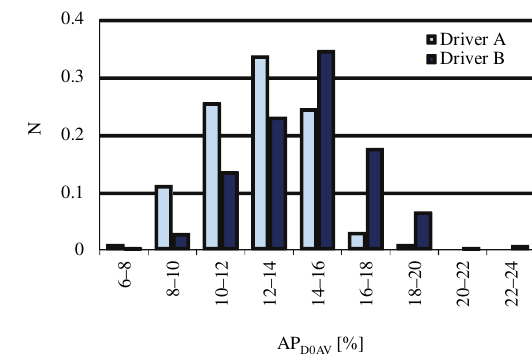
Fig. 28. Average relative position of accelerator pedal, excluding vehicle stops and zero position, in urban driving conditions